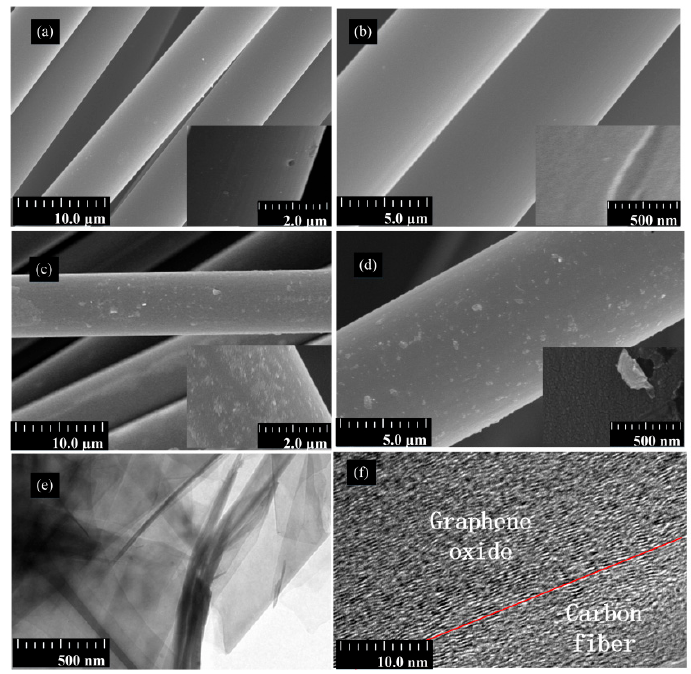
Figure 4. Field emission scanning electron microscopy image of CF. Panels ( a , b ) show the defect of CF, Panels ( c , d ) is images of CF–GO; panels ( e , f ) show the transmission electron microscope image of GO–CF.